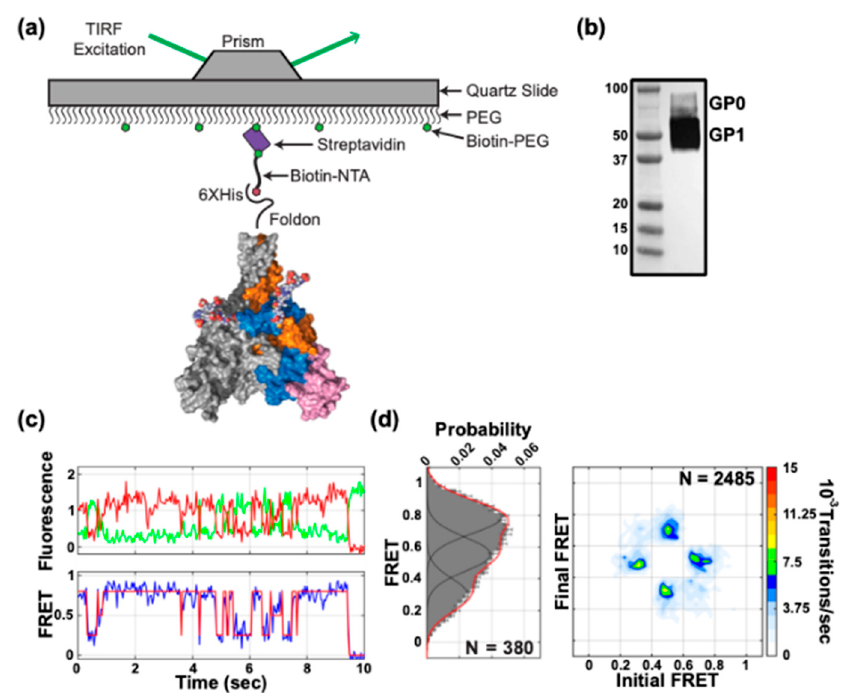
Figure 3. Conformational dynamics of EBOV GP ∆ TM. ( a ) smFRET imaging of GP ∆ TM trimers containing a single fluorescently-labelled protomer within an otherwise wild-type GP ∆ TM trimer were surface-immobilized via biotin-NTA on a streptavidin-coated quartz microscope slide for smFRET imaging with TIRF microscopy. ( b ) Western blot of purified GP ∆ TM used in smFRET imaging using an anti-GP1 antibody (H3C8). ( c ) Representative fluorescence trace (top) showing fluorescence intensity over time for a donor (LD550; green) and acceptor (LD650; red) fluorophore pair on a single GP ∆ TM trimer, and the corresponding FRET trajectory (bottom). Overlaid on the FRET trajectory is the idealization (red) resulting from HMM analysis. ( d ) (Left) Population FRET histogram for GP ∆ TM trimers composed of FRET trajectories summed over the observation window. Overlaid on the histograms are Gaussian distributions with means 0.3, 0.5 and 0.7 that reflect the results of HMM analysis. N indicates the number of trimers in the population histogram. (Right) Transition density plot (TDP) displaying the relative frequencies of observed transitions generated from idealizations of individual FRET trajectories. N indicates the total number of transitions within the population of trimers analyzed. Table 1. Förster resonance energy transfer (FRET) state occupancies determined through hidden Markov modeling.